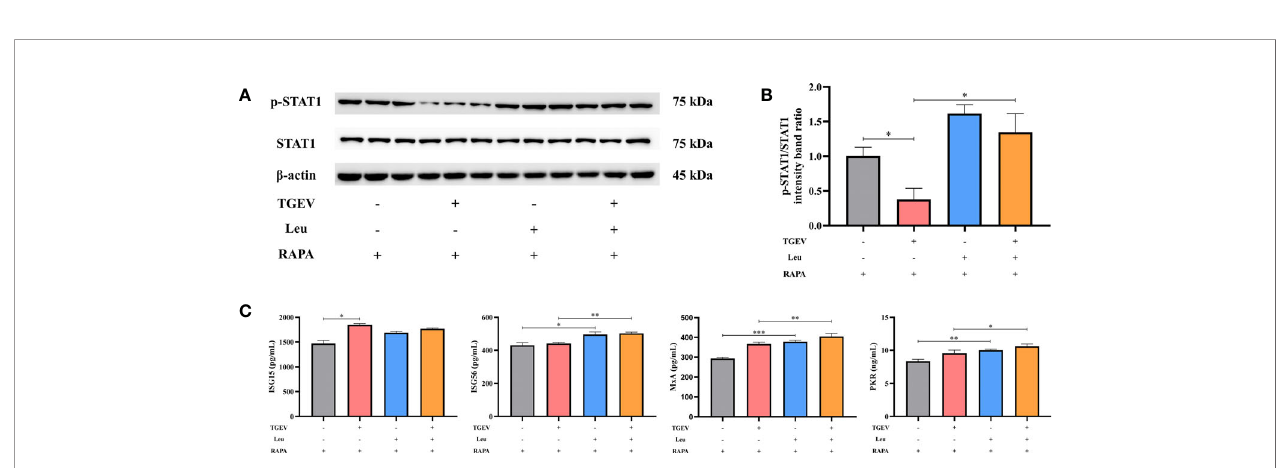
FIGURE 8 | The expressions of STAT1 and ISGs increased by Leu and RAPA pretreatment in TGEV-infected cells. (A) Both p-STAT1 and T-STAT1 levels were detected by western blot. (B) Quantitation of bands to demonstrate the protein level of p-STAT1/STAT1. Data express the means ± SEMs (n = 3). (C) The expressions of ISGs (ISG15, ISG56, MxA and PKR) were detected by ELISA. Data express the means ± SEMs (n = 3). The symbol * indicates statistically signi fi cant differences ( P < 0.05), ** P < 0.01 and *** P < 0.001.